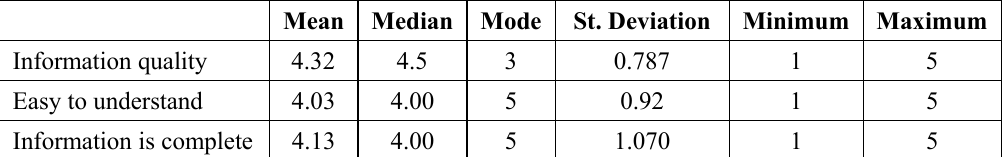
Table 4 . Statistical Results of Information Quality